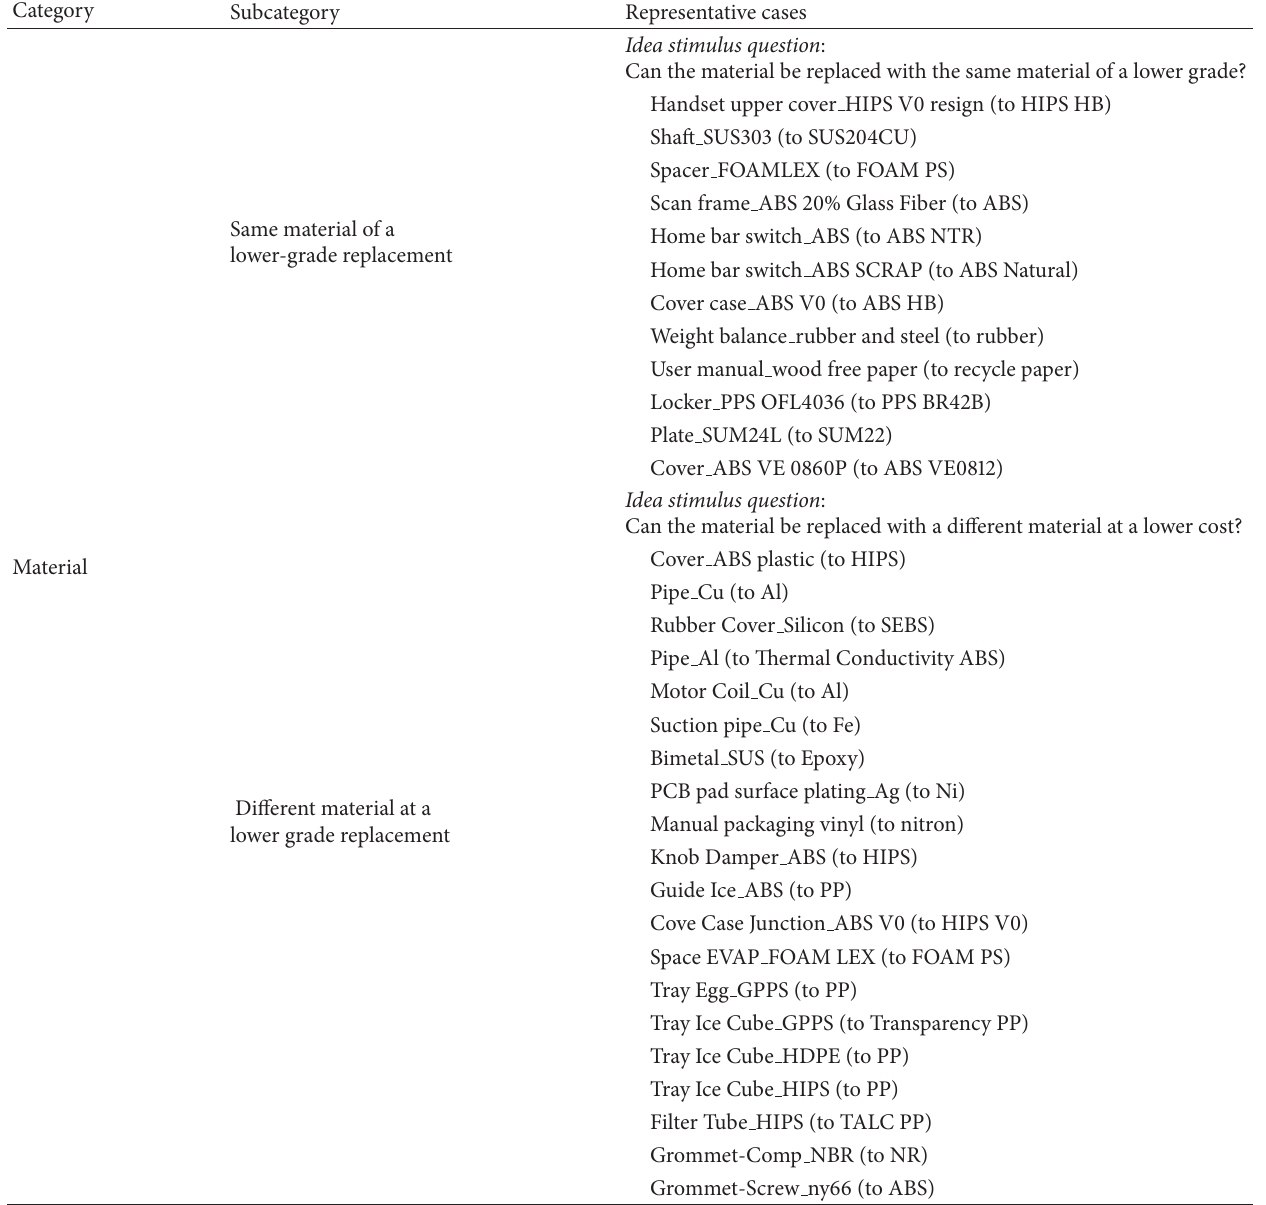
Table 1: Material checklist and representative